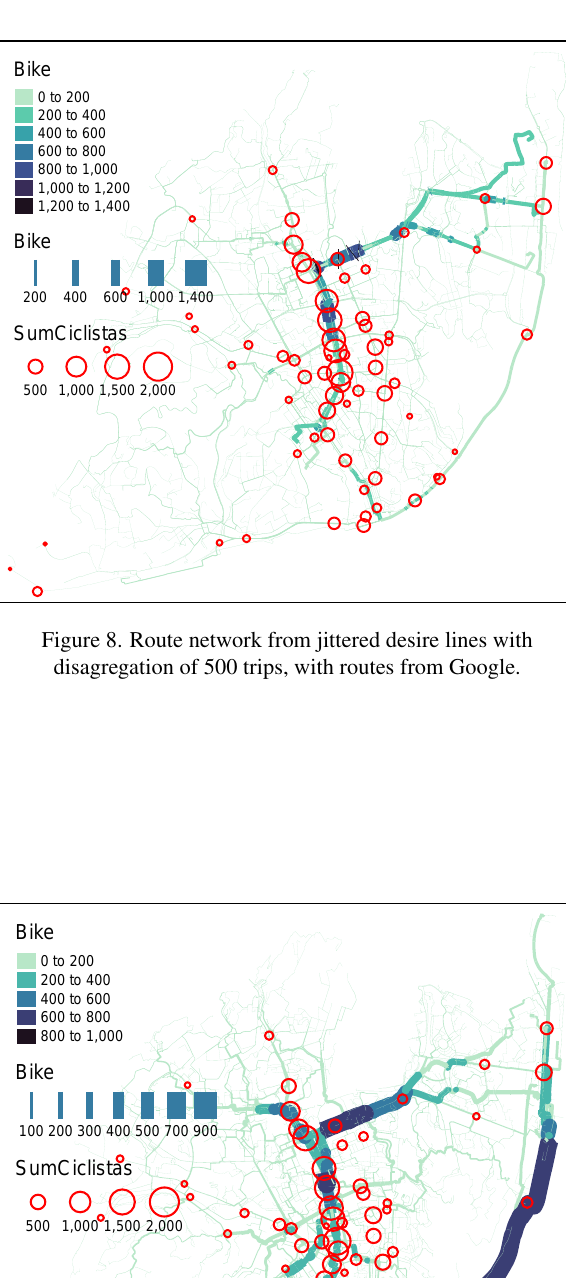
Table 1. Results showing counter/model fit for route